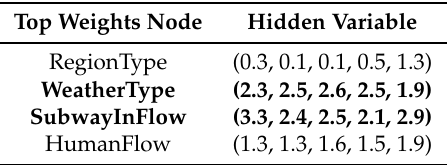
Table 5. Explanations of results based on propagation graph features for traffic accident inference.